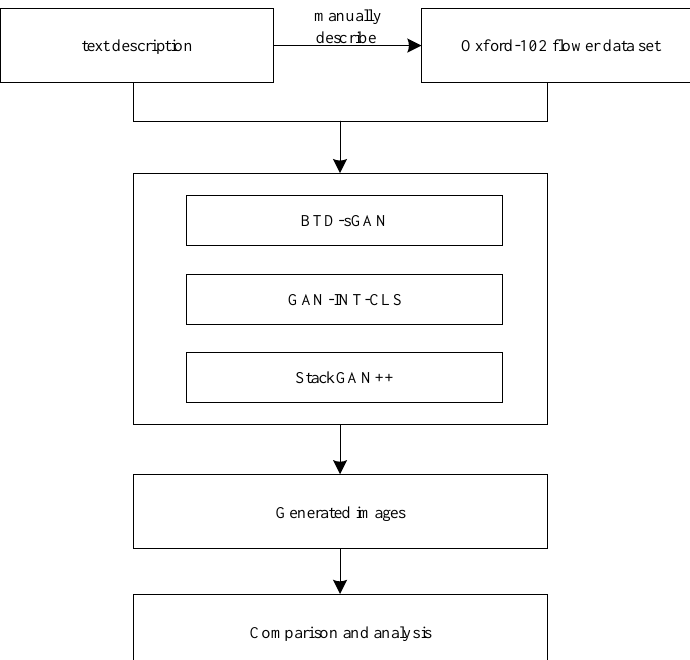
Figure 9. Experimental process of model comparison. The 3KB text descriptions in the test set are randomly selected for testing. The gener- ated results of the different models are shown in Figure